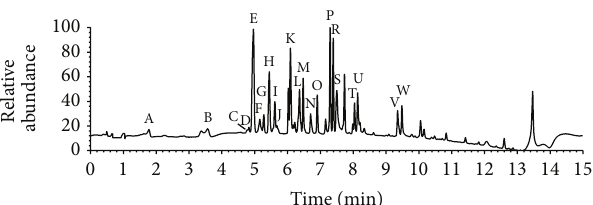
Figure1:UVchromatogramofinvestigatedstandardsat280 nm:Gallicacid(A);Protocatechuicacidand(+)-Gallocatechin(B);Aesculin(C); ( − )-Epigallocatechin (D); p -Hydroxybenzoic and Gentisic acid (E); Chlorogenic acid (F); (+)-Catechin (G); Caffeic acid (H); ( − )-Epicatechin (I); ( − )-Gallocatechin gallate (J); Rutin (K); p -Coumaric and Ellagic acid (L); Naringin (M); ( − )-Epigallocatechin gallate (N); Myrcetin (O); cis,trans -Abscisic acid (P); Luteolin (R); Quercetin and trans -Resveratrol (S); Naringenin (T); Apigenin (U); Chrysin and Pinocembrin (V); Hesperetin and Galangin (W).